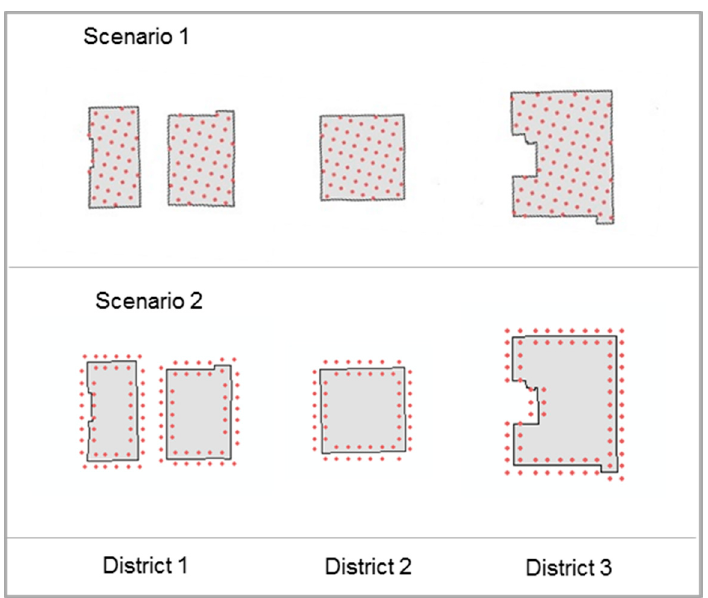
Figure 4. Borehole allocation for districts.